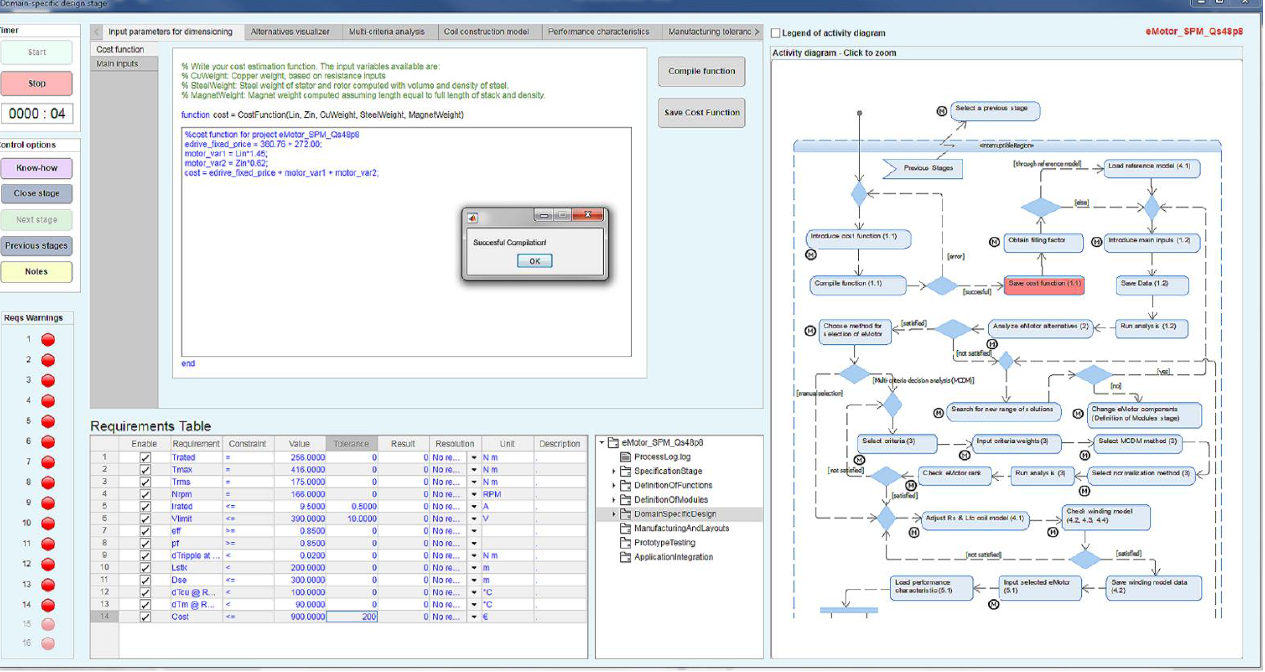
Figure 14. User interface for the domain-specific design stage of the KBE application.